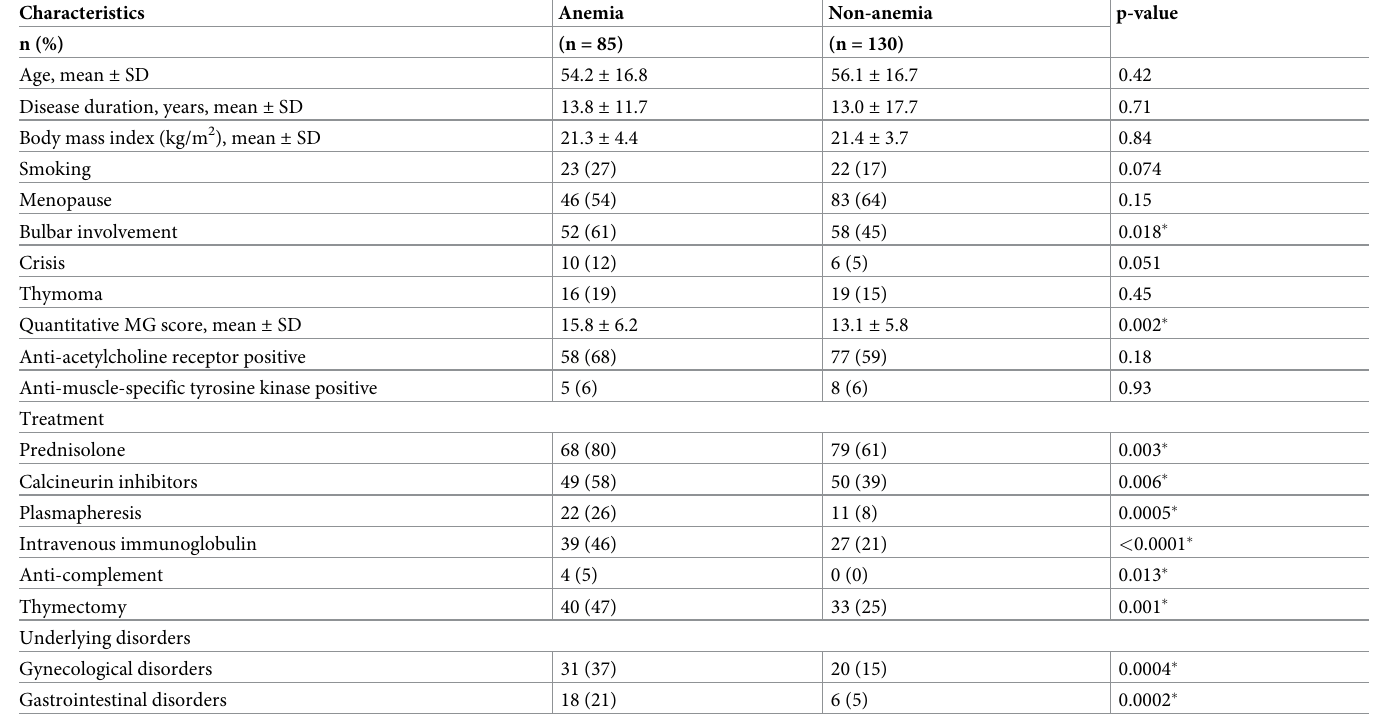
Table 1. Comparison between female MG patients with and without moderate or severe anemia. Characteristics